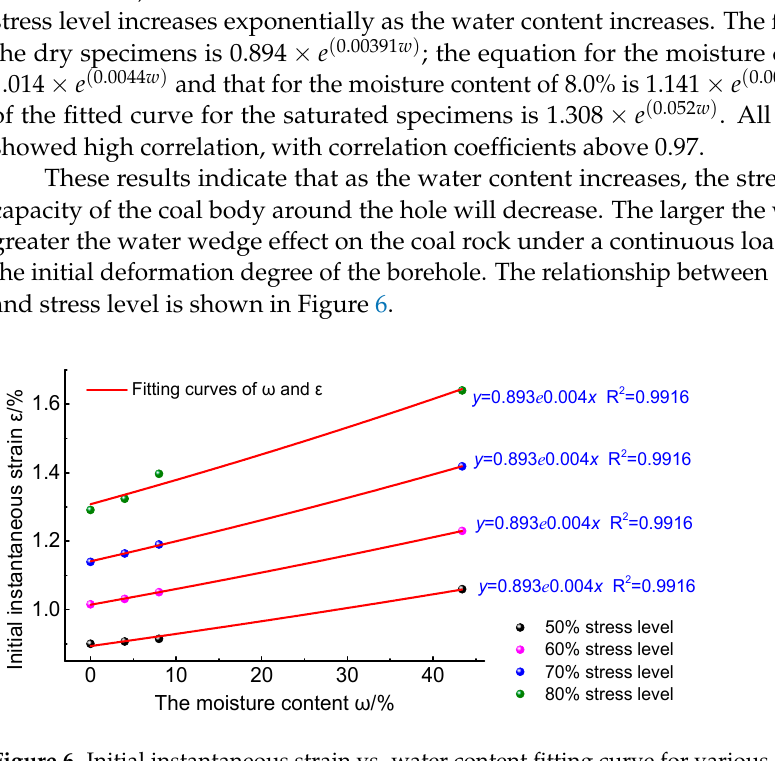
Figure 6. Initial instantaneous strain vs. water content fitting curve for various stress levels.